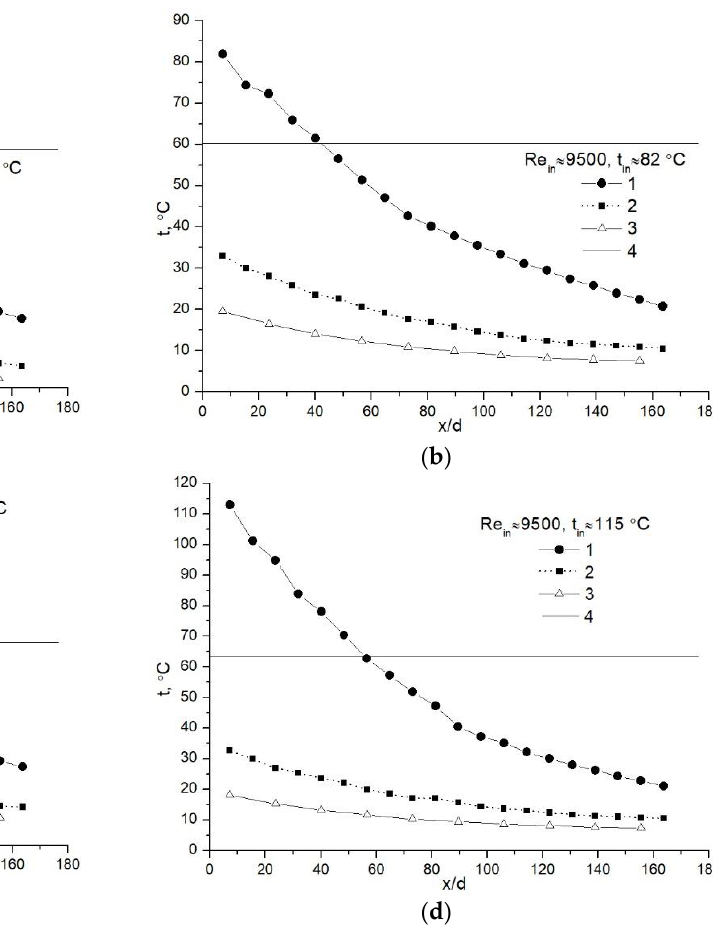
Figure 2. Temperature variation in the heat exchanger at Re in ≈ 9500, different inlet flue gas temperatures and cooling water flow rates of 60 kg/h ( a , c ) and 120 kg/h ( b , d ): (1) flue gas in the tube center, (2) the inner wall of the tube, (3) cooling water, (4) the dew point temperature.